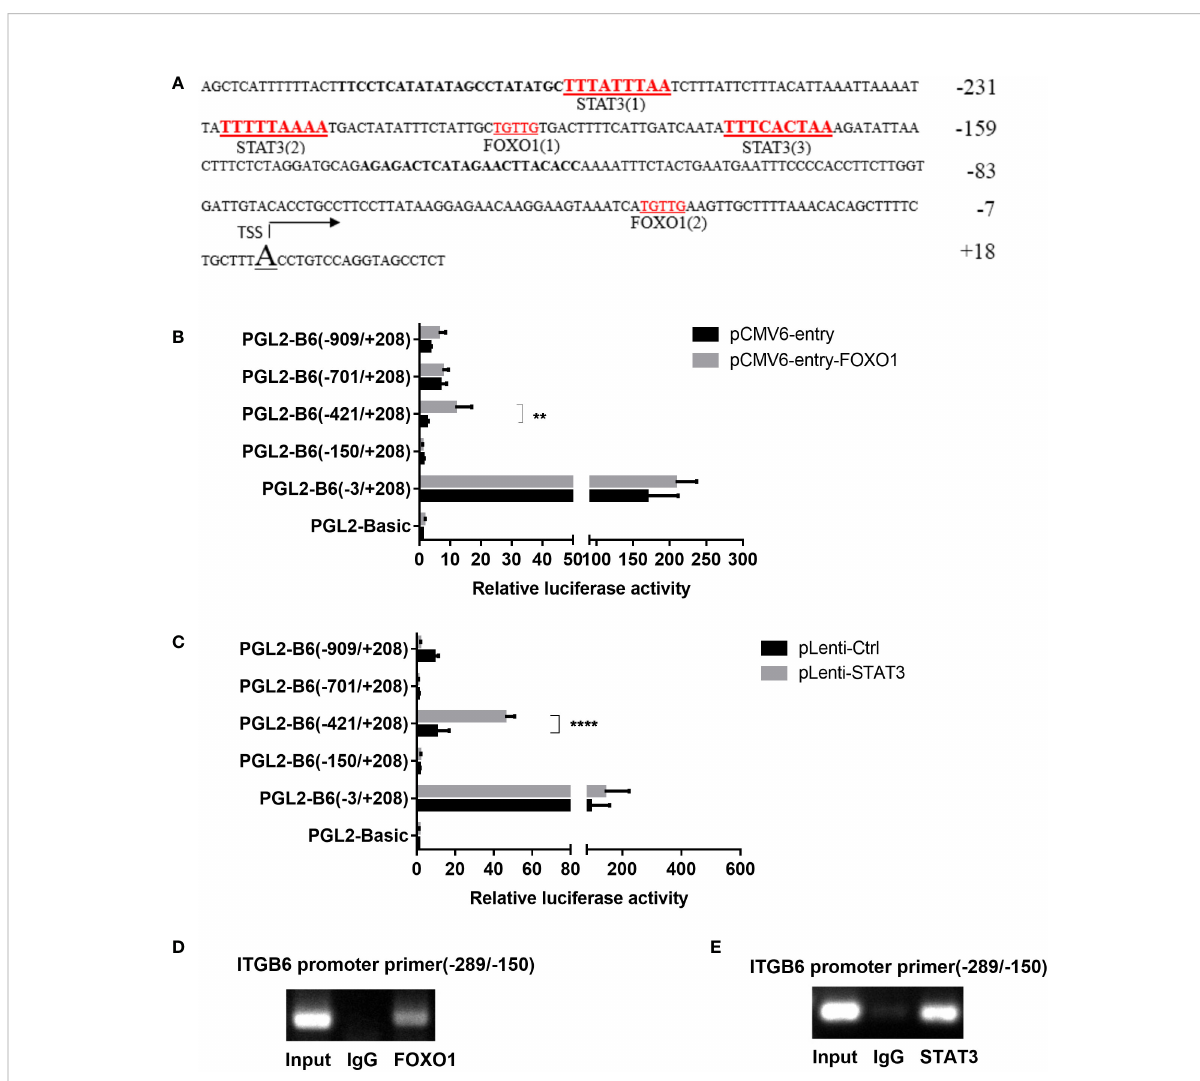
FIGURE 2 FOXO1 and STAT3 binding sites located at the ITGB6 promoter. (A) Potential binding sites at the ITGB6 promoter were predicted by the JASPER database. All numbers presented are relative to the TSS of the human ITGB6 gene. There are three latent STAT3 binding sites and two FOXO1 binding sites between − 26 and +18 of the ITGB6 promoter. (B, C) Effect of FOXO1 (B) and STAT3 (C) overexpression on ITGB6 promoter activity in HaCaT. Luciferase reporter constructs containing various lengths of the ITGB6 promoter, or the empty plasmid pGL2-basic, were co- transfected with pRL-TK and with either FOXO1 or STAT3-overexpressing plasmid into HaCaT cells. Luciferase activity was measured at 48 h after transfection. The luciferase value of the pGL2-basic was set to a value of one. Relative promoter activities are presented on the right (mean ± SEM, at least three independent experiments) and were analyzed using one-way ANOVA. (D, E) Measurement of FOXO1 and STAT3 binding to the ITGB6 promoter. ChIP assay was performed using anti-FOXO1 antibody (D) , anti-STAT3 antibody (E) , or IgG as a control in HaCaT